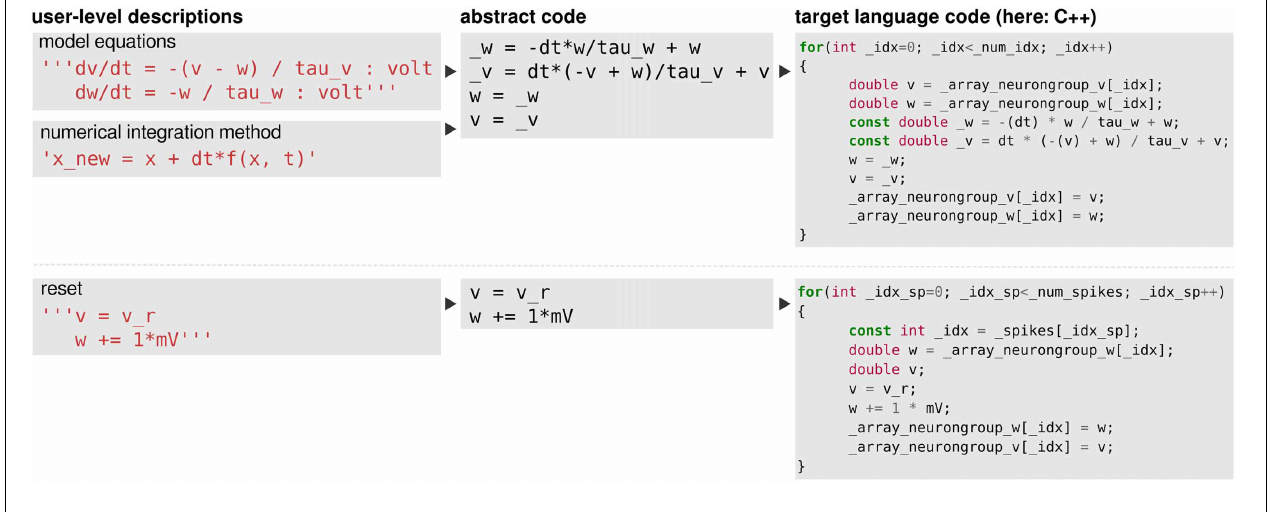
FIGURE 7 | The code-generation process. Left column: user level descriptions are given either as a set of equations with a numerical integration method, or directly as a sequence of mathematical statements. Middle column: in both cases the user level description is turned into a